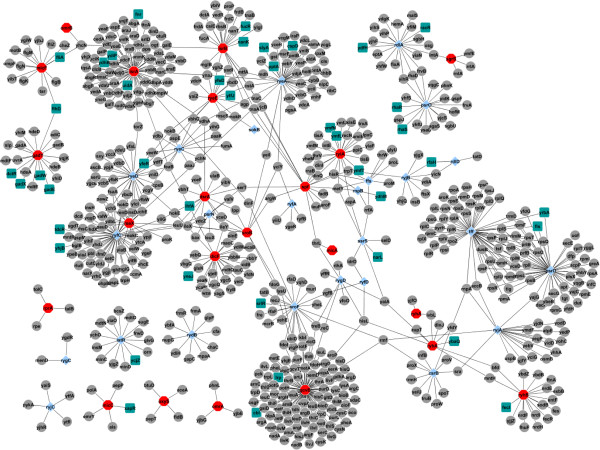
Global sRNA-target network of
E. coli
. CLR algorithm was applied to 759 RMA-normalized expression arrays to reverse-engineer whole-genome sRNA regulatory network at an FDR corrected P value < 0.005.